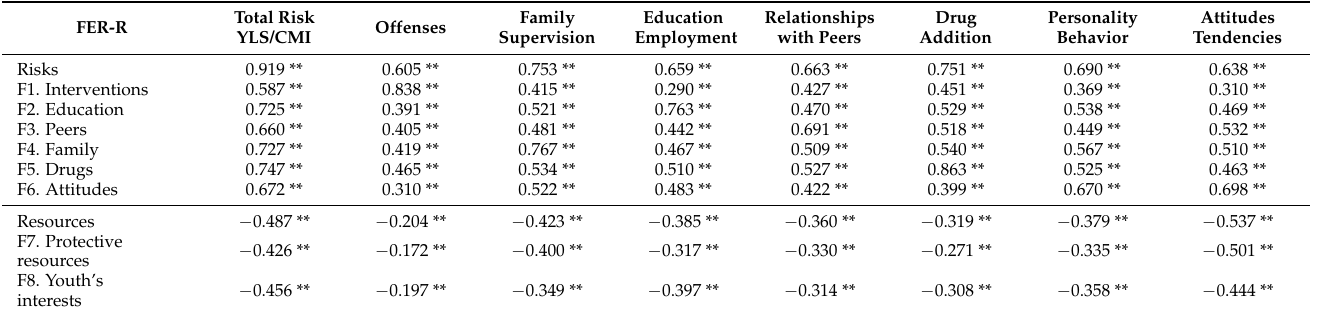
Figure 4. Mapping of confirmatory bifactor analysis of two facets of resources on the FER ‐ R.